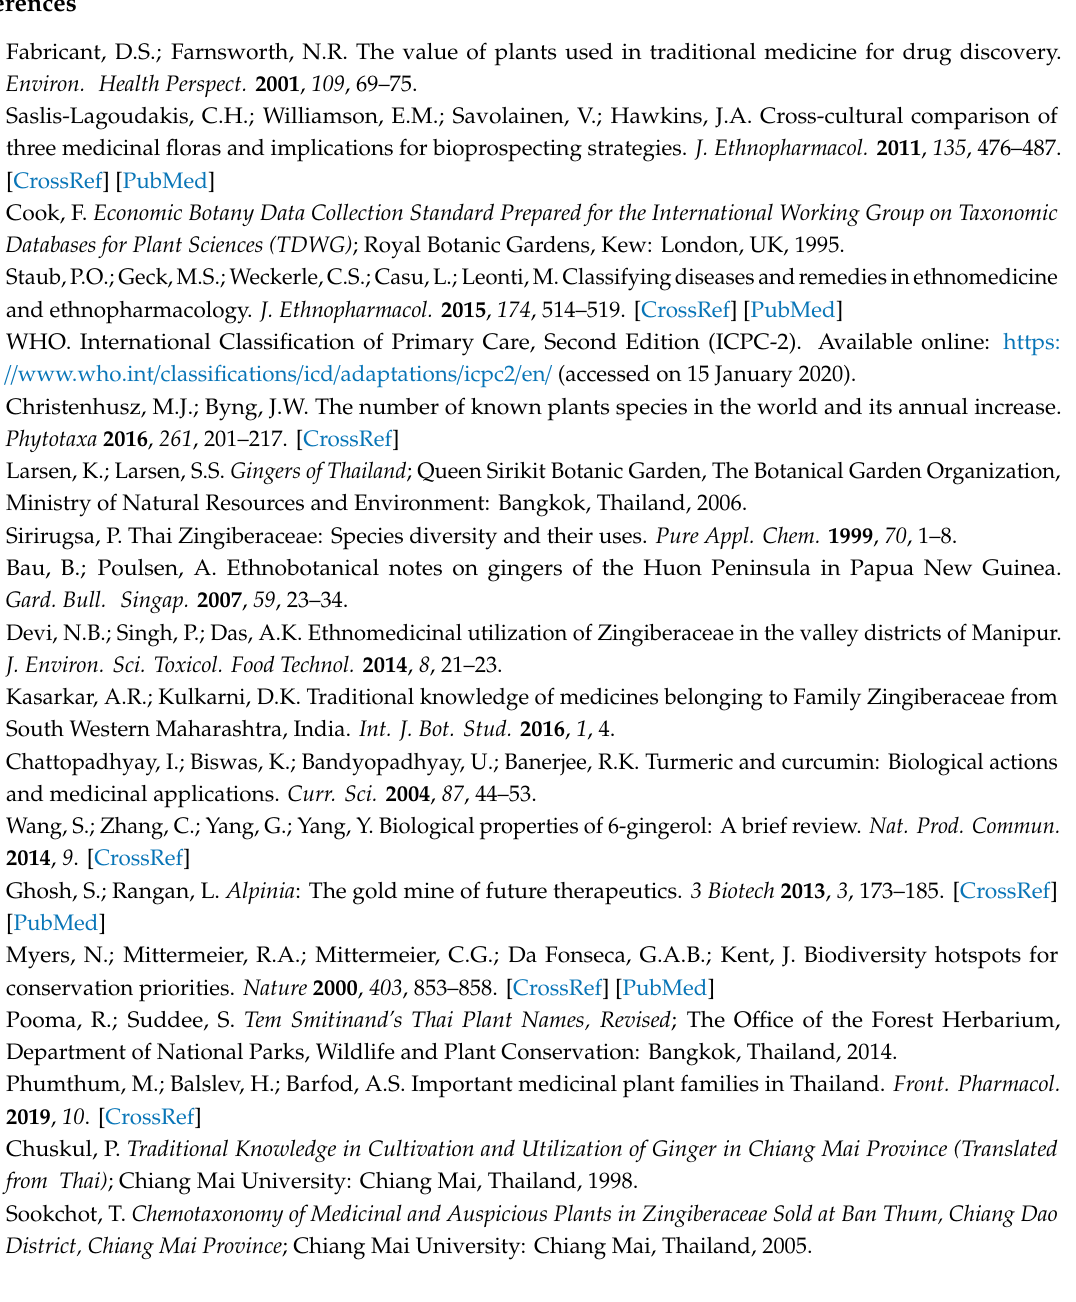
Table S1: Ethnomedicinal uses of gingers in Thailand; Table S2: Fidelity Level (FL) of gingers for treatments of some symptoms in Digestive system